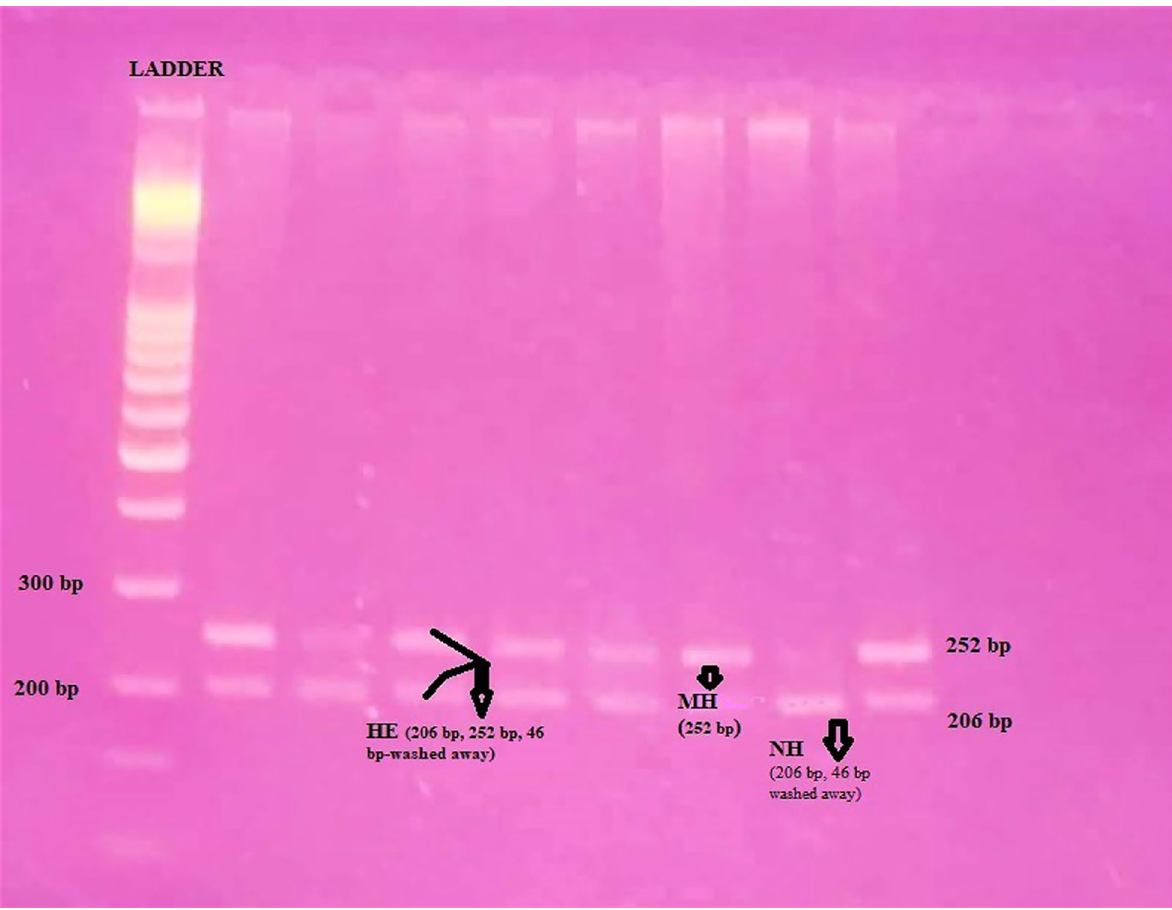
Fig. 1 Restriction enzyme (HpyCH4IV) digestion fragments of SMAD4 gene polymorphism (2% agarose gel). Normal Homozygous (NH) has bands of 206 bp and 46 bp (washed away), Heterozygous has bands of 206 bp, 252 bp and 46 bp (washed away), Mutant Homozygous (MH) has band of 252 bp